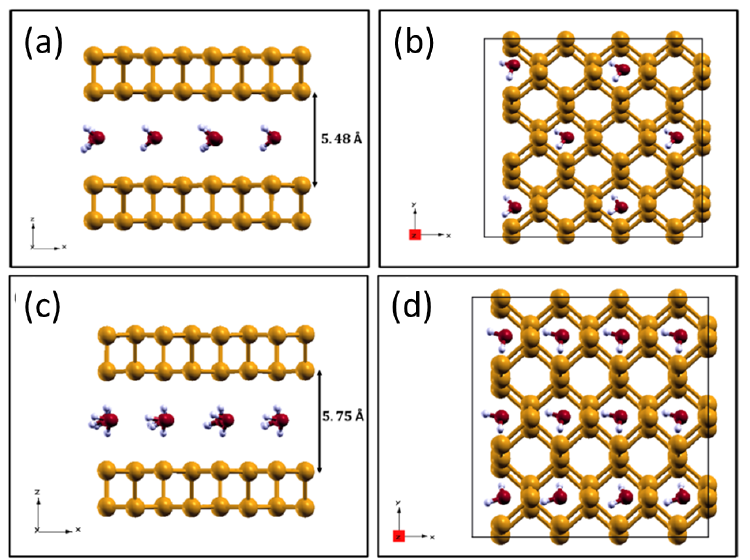
Figure 7. Side view (Panels ( a , c )) and top view (Panels ( b , d )) of a phosphorene bilayer with 25% (upper panels) and 50% (lower panels) of superficial intercalated water coverage.